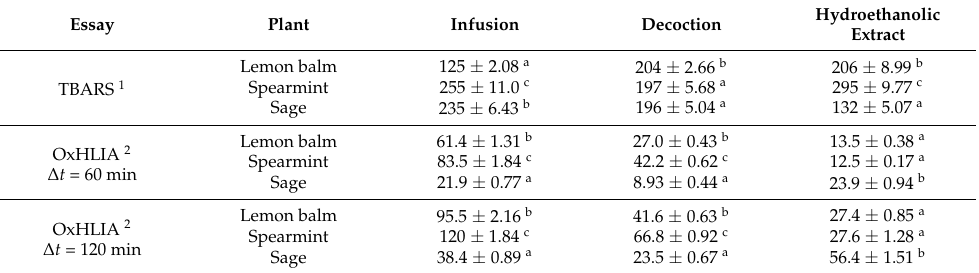
Table 3. Antioxidant activity of plant extracts expressed as half-maximal inhibitory concentration (IC 50 , µ g/mL) measured by the TBARS (mean ± SD, n = 9) and OxHLIA (mean ± SD, n = 3) essays. Essay Plant Infusion Decoction Hydroethanolic Extract Lemon balm 125 ± 2.08 a 204 ± 2.66 b 206 ± 8.99 b Spearmint 255 ± 11.0 c 197 ± 5.68 TBARS 1